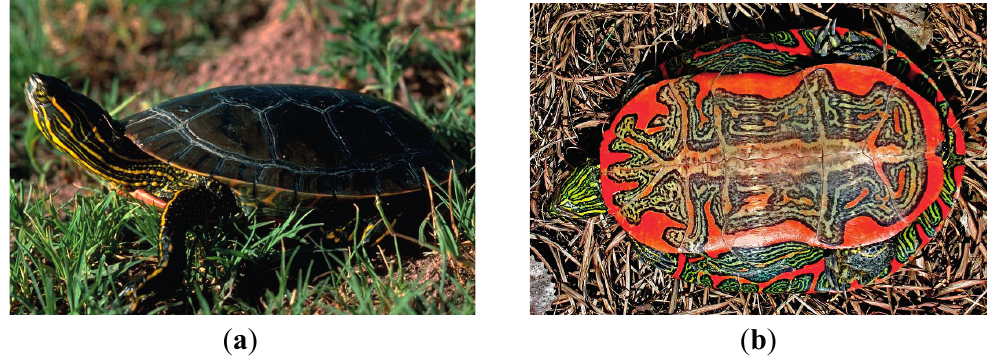
Figure 2. Western Painted Turtle Chrysemys picta bellii . ( a ) Western painted turtle. Photo by Gary M. Stolz, U.S. Fish and Wildlife Service in the Public domain [26]. ( b ) Underside of a Western Painted Turtle. Photo by Matt Young